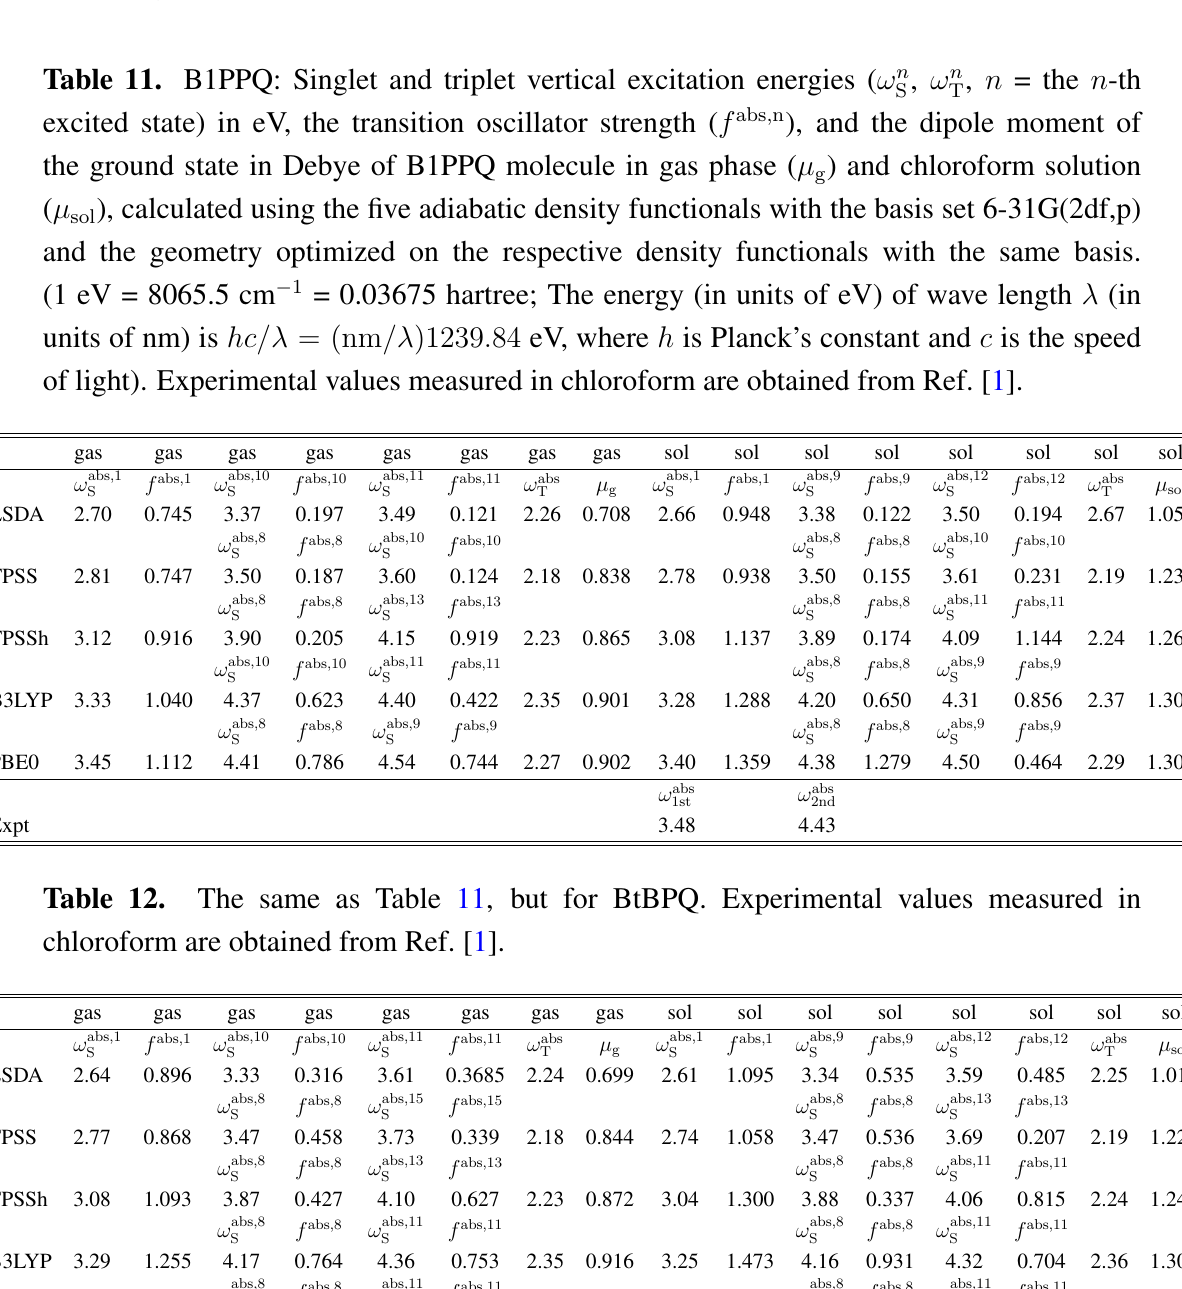
, ω n , n = the n -th S T ) and chloroform solution g